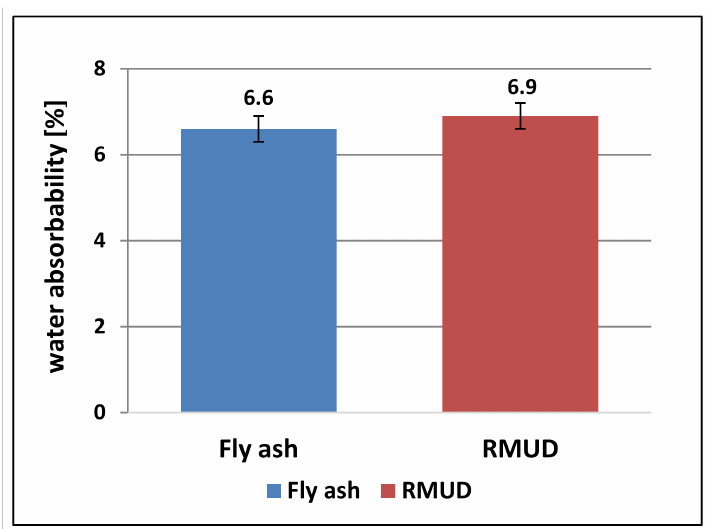
Figure 7. Water absorbability of concrete.